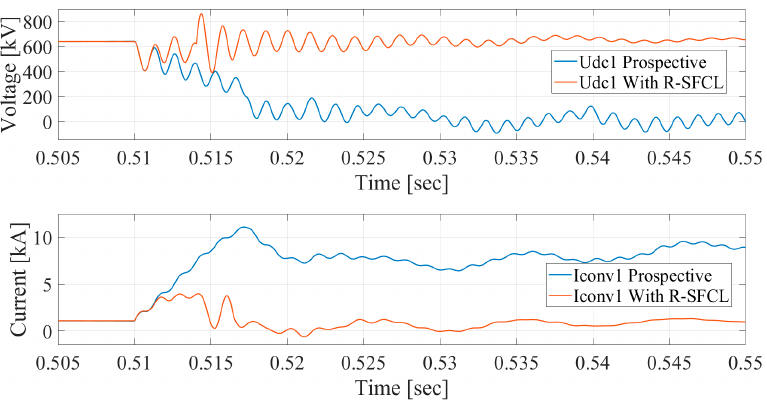
Figure 18. Converter 1 behavior with and without current limiter under pole-to-pole fault in Link 12 near Bus1 .